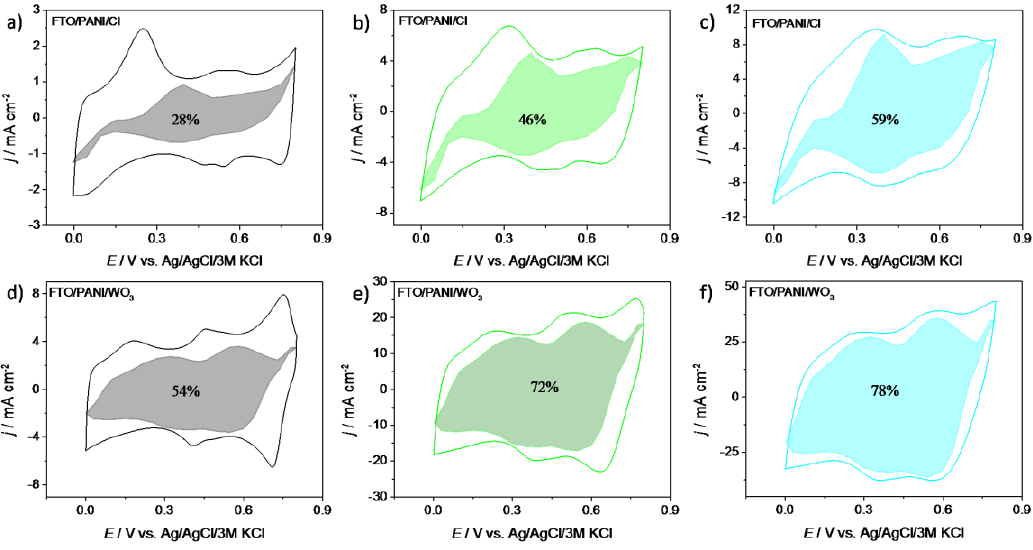
Figure 6. Charge storage contributions at ( a ) 10 mV s −1 , ( b ) 50 mV s −1 and ( c ) 100 mV s −1 of FTO/PANI/Cl electrode material and at ( d ) 10 mV s −1 , ( e ) 50 mV s −1 and ( f ) 100 mV s −1 of FTO/PANI/WO 3 electrode material.